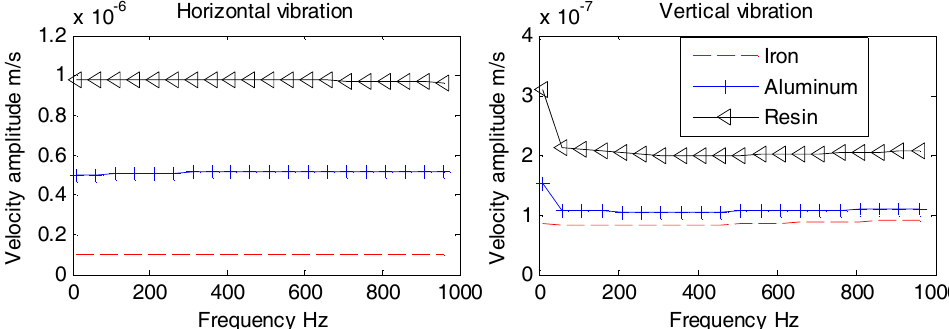
Figure 13. Vibration velocity amplitudes of the OBSs with different densities under incident angle of 10°.